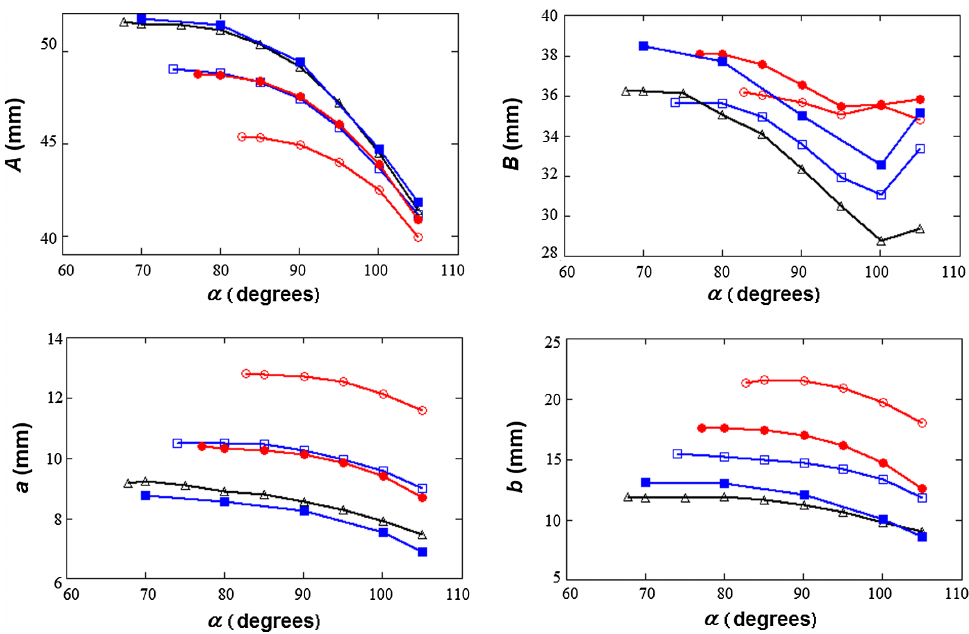
FIG. 18. Elliptic half-axes for the previous figure. Designation of points are the same. See details in Sec.